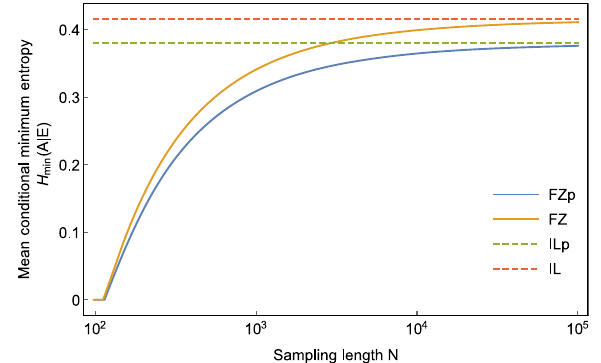
Fig. 6 Conditional minimum entropy H min ( A ∣ E ) as a function of the sampling length with the fi nite size (FS) and in fi nite length (IL). FZ and IL represent the rates without the afterpulse, and FZP and ILP represent the rates with the afterpulse ^ p α ¼ 5 % . Assume that pulses with coherent states contain ν = 10